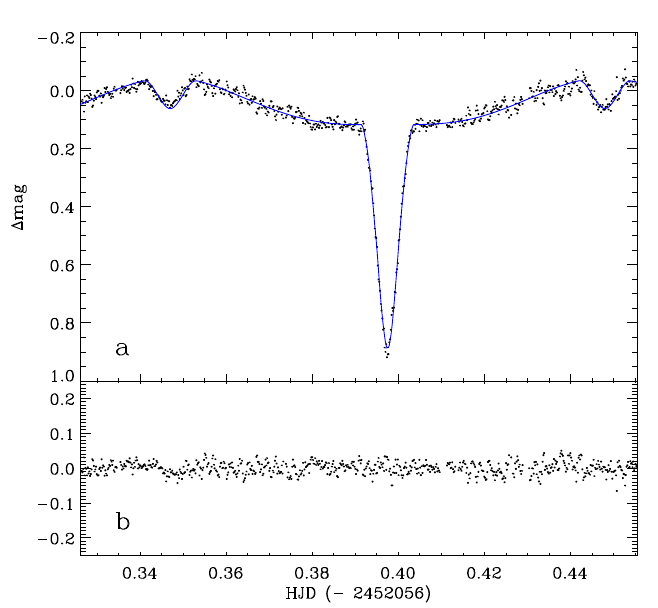
Fig. 3. (a) An observed light curve (dots) with the unperturbed syn- thetic one superimposed as a continuous line. (b) The pulsations of sdB after removal of the unperturbed light curve.